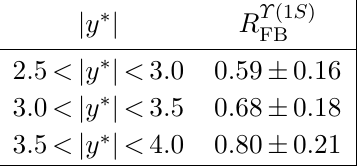
Table 17 . (cid:7) (1 S ) forward-to-backward ratio, R (cid:7) (1 S ) range 0 < p T < 25 GeV =c